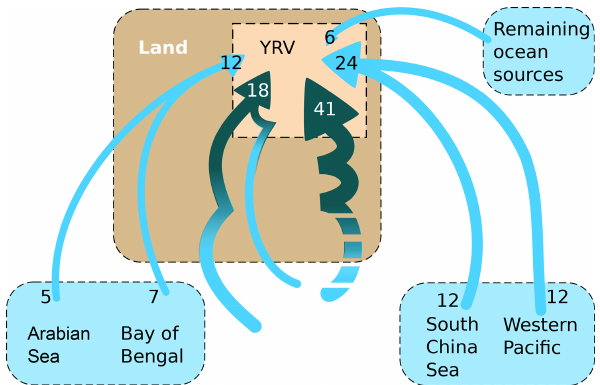
Figure 11. Moisture sources of the YRV during April–September. All numbers are contributions expressed as the percentage of YRV precipitation. Light blue arrows represent direct ocean contribu- tion, while light-to-dark arrows represent oceanic moisture with un- known origin recycled once (left) or more than once (right) before precipitating over the